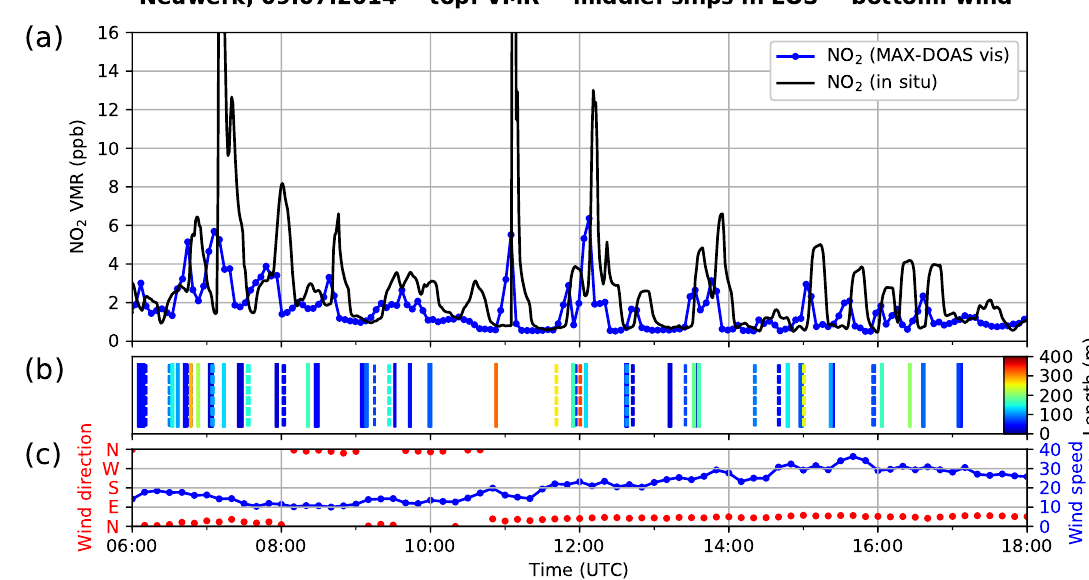
Figure 11. MAX-DOAS and in situ NO 2 volume mixing ratio, AIS and wind data on 9 July 2014: (a) MAX-DOAS (visible) and in situ NO 2 VMRs. (b) Vertical bars indicate that a ship is in the line of sight of the instrument. Solid bars: ship moves from left to right (west to east); dashed bars: vice versa; colors represent ship length. (c) Wind speed and direction measured on Scharhörn